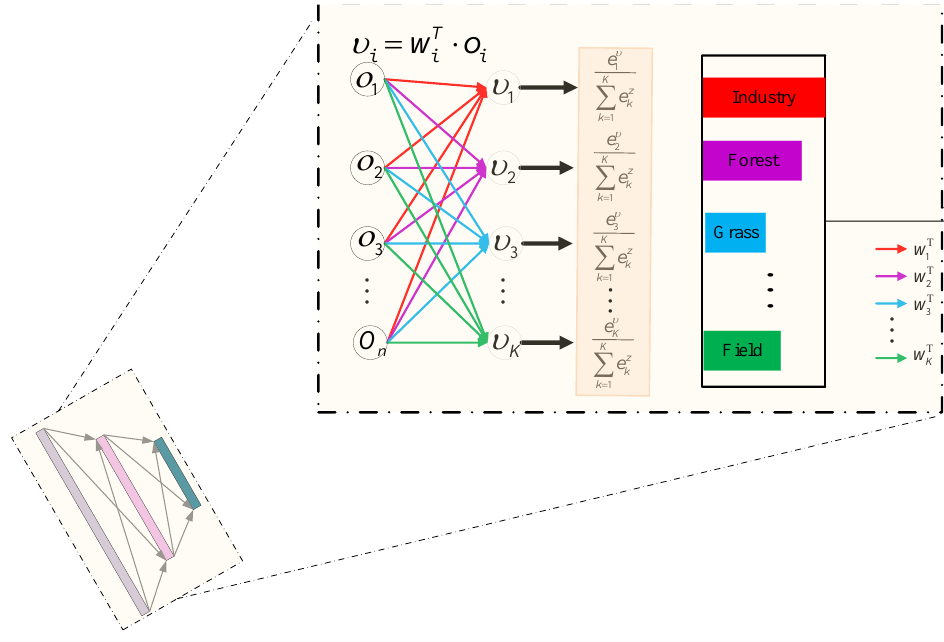
Figure 4. The structure of group 8. Group 8 is composed of the global average pooling layer (GAP), the fully connected layer (FC) and the Softmax classifier, which is used to convert the feature information extracted by convolution into the probability of each scene. Because the features ex- tracted by convolution contain spatial information, if these features are directly mapped into feature vectors through the fully connected layer, the spatial information of the fea- tures will be destroyed. Global average pooling will not destroy the spatial information of features. Therefore, global average pooling should be carried out first and then the fully connected layer. Suppose that the output of the last convolution layer is represents the real number set, and H , W and n repre-